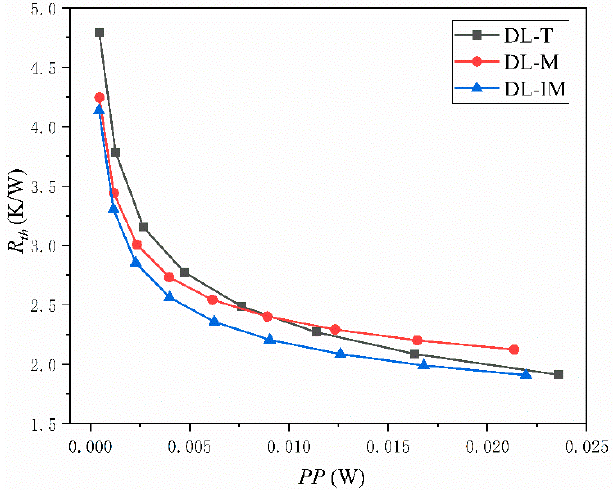
Figure 11. Thermal resistance of DL-T, DL-M and DL-IM at different pumping powers.